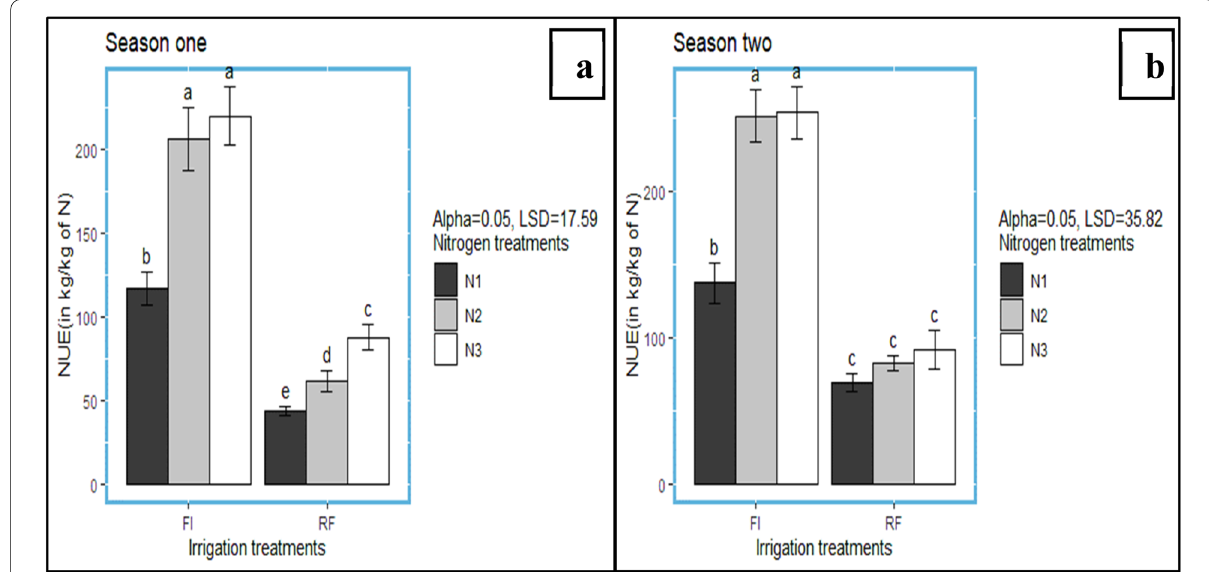
Fig. 5 Means separation of NUE of different growing seasons. Different letters indicate significant difference.